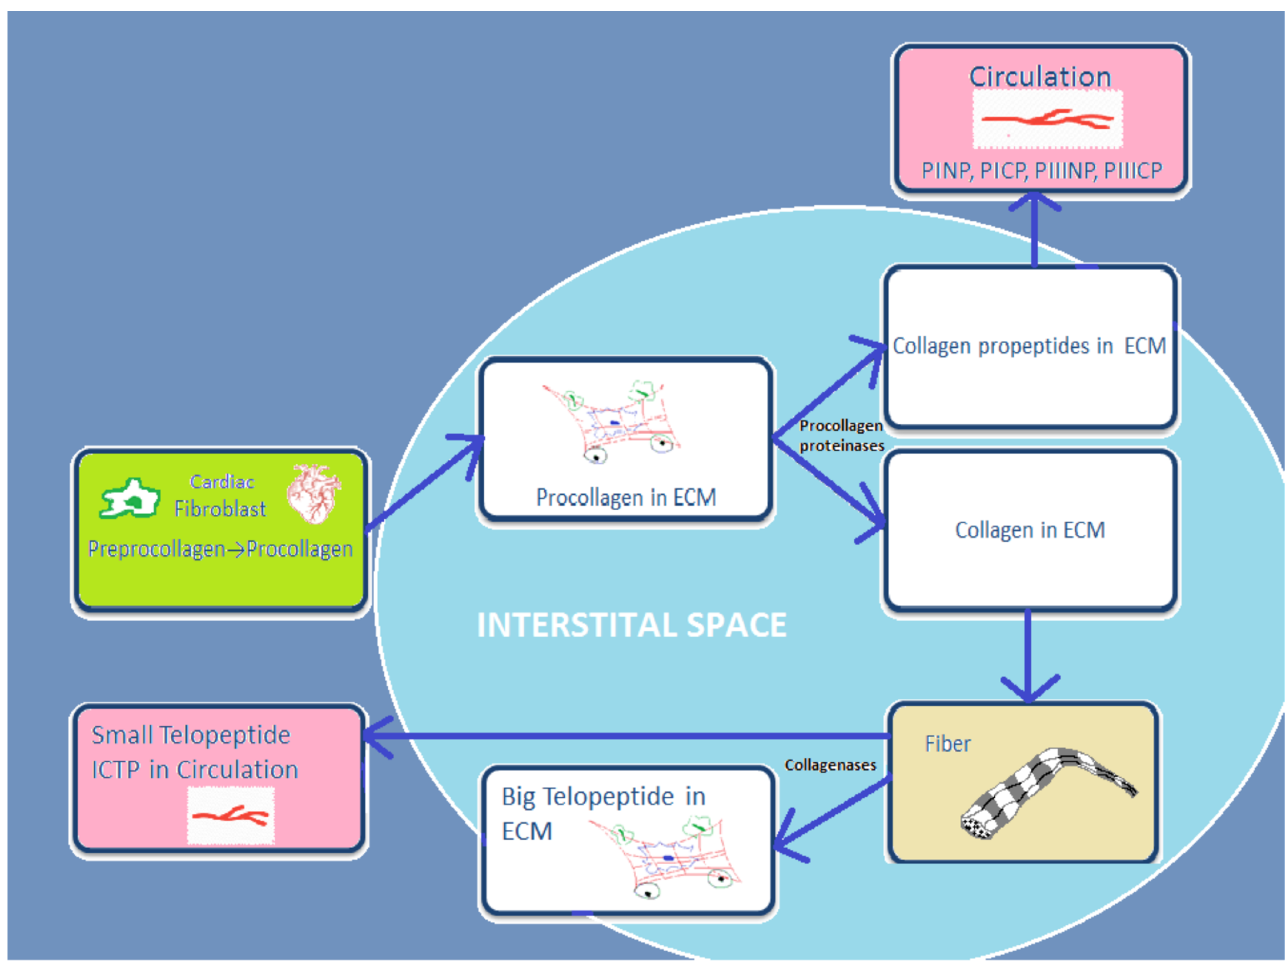
Figure 1. Schematic presentation of basic stages from process of synthesis and degradation of collagen I and III. I and